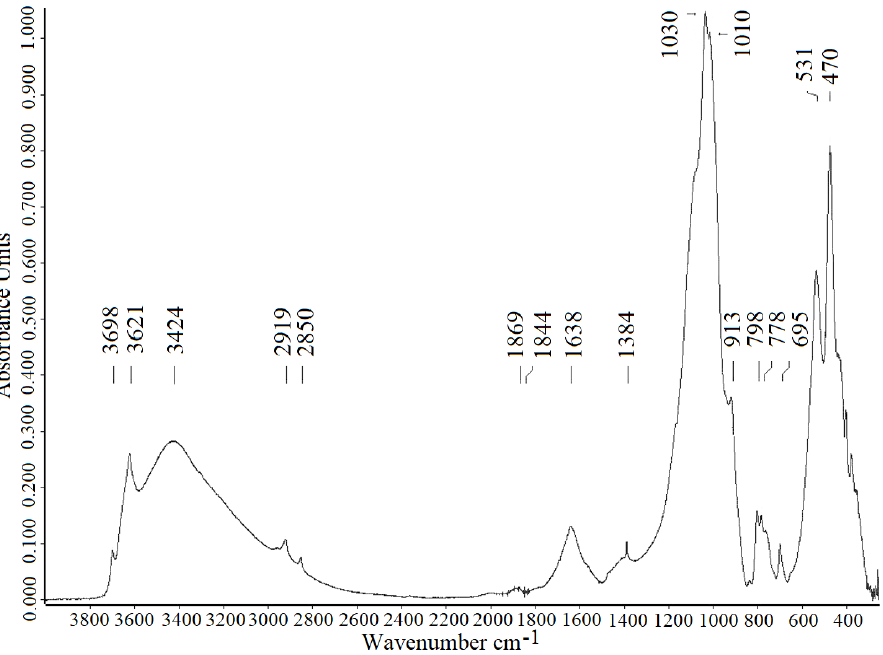
Figure 3. FTIR spectra for the representative sample of soil from